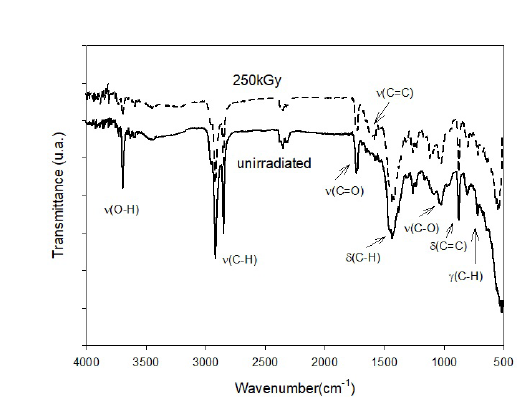
Figure 4. FTIR spectra of unirradiated or gamma-irradiated at 250 kGy green LLDPE (jacket outer surface) in air, at room temperature.